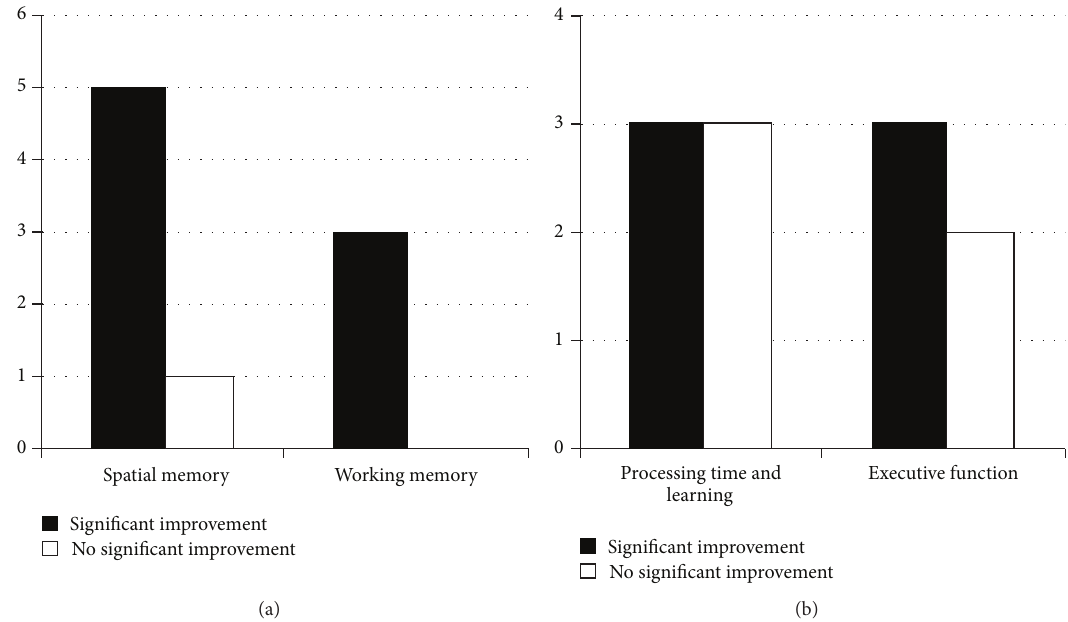
Figure 4: Effects of AE on cognitive performance: frequency of AE-induced positive (black bars) and negative (white bars) findings in animal studies (a) investigating spatial memory ( 𝑛 = 6 ) and working memory ( 𝑛 = 3 ) and clinical trials (b) assessing processing time and learning ( 𝑛 = 6 ) and executive function ( 𝑛 = 5